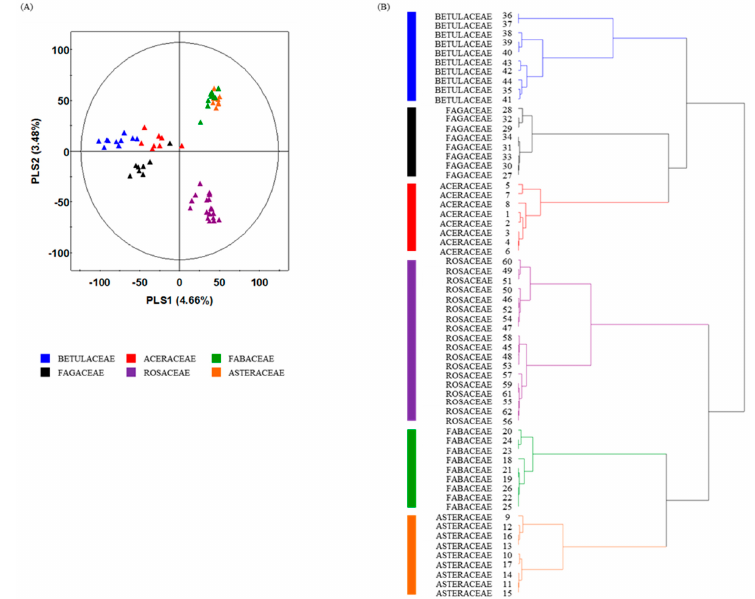
Figure 1. Partial least squares discriminant analysis (PLS-DA) score plot ( A ) and hierarchical cluster analysis (HCA) dendrogram based on PLS-DA results ( B ) derived from the ultrahigh performance liquid chromatography (UHPLC)-linear trap quadrupole-ion trap (LTQ-IT) mass spectrometry/mass spectrometry (MS/MS) data of 62 indigenous Korean plant species. Samples are colored according to the family.